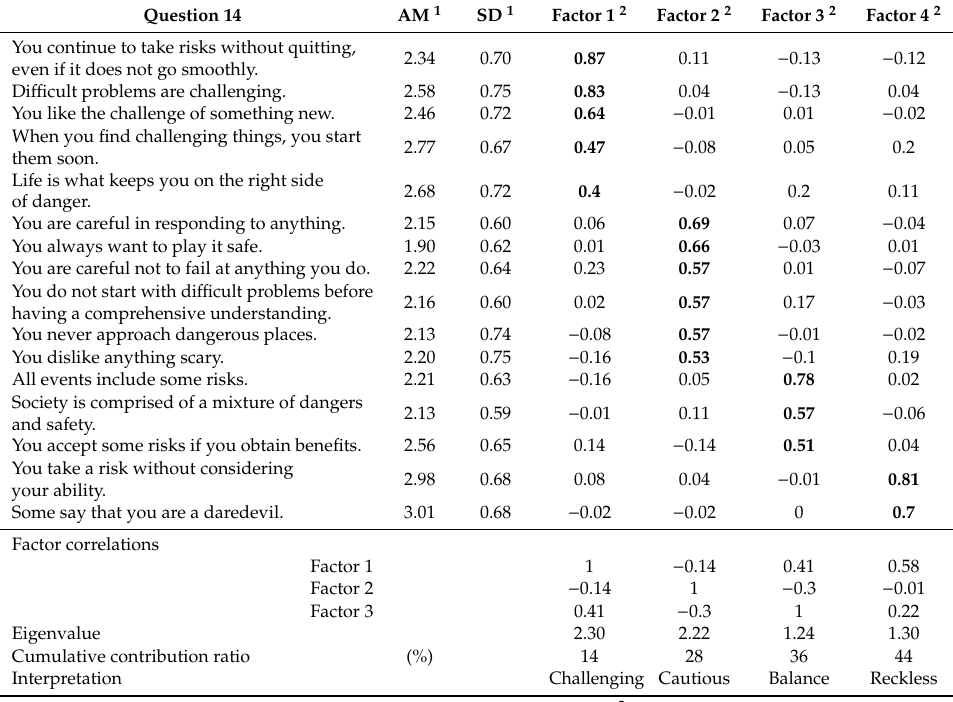
Table 4. Arithmetic mean, standard deviation, and factor loading matrix for risk acceptance and